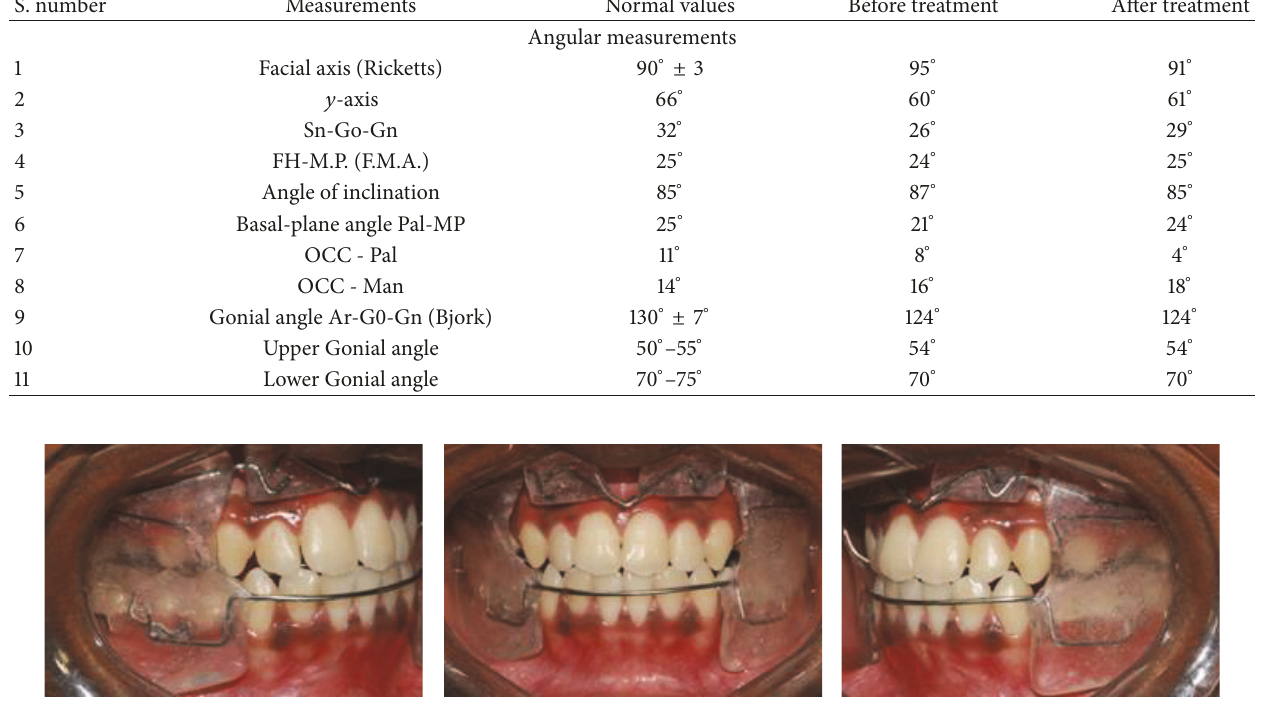
Figure 6: Retention with